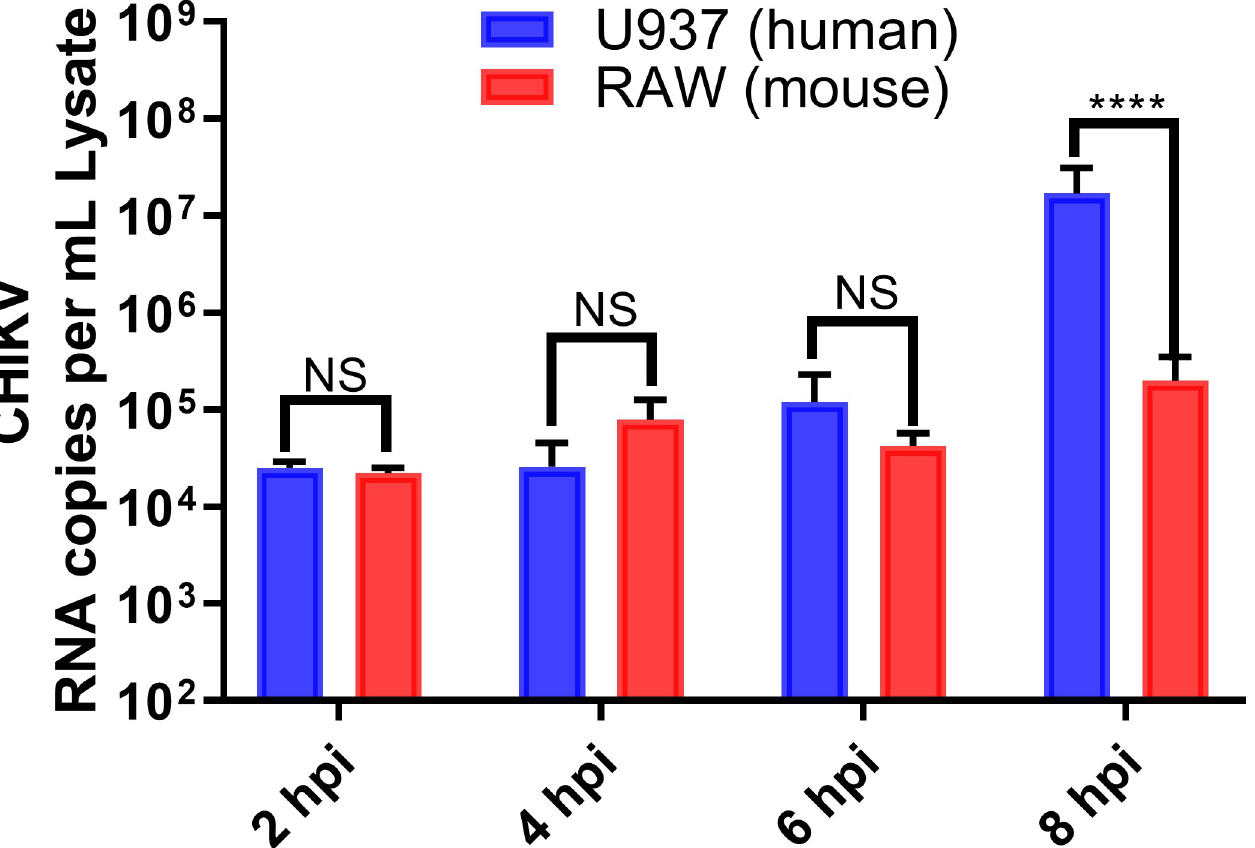
Fig 3. CHIKV genome levels in human and murine macrophages shortly after infection. Intracellular CHIKV RNA copies were quantified via RT-qPCR at stated times (hpi). Data show mean values of three independent experiments with a total of n = 9, MOI = 5. Statistically significant p values are denoted with an asterisk between compared groups. Statistical significance was determined using multiple t-test corrected using Holm-Sidak method. � P < 0.05; �� P < 0.01; ��� P < 0.001; NS, not significant.